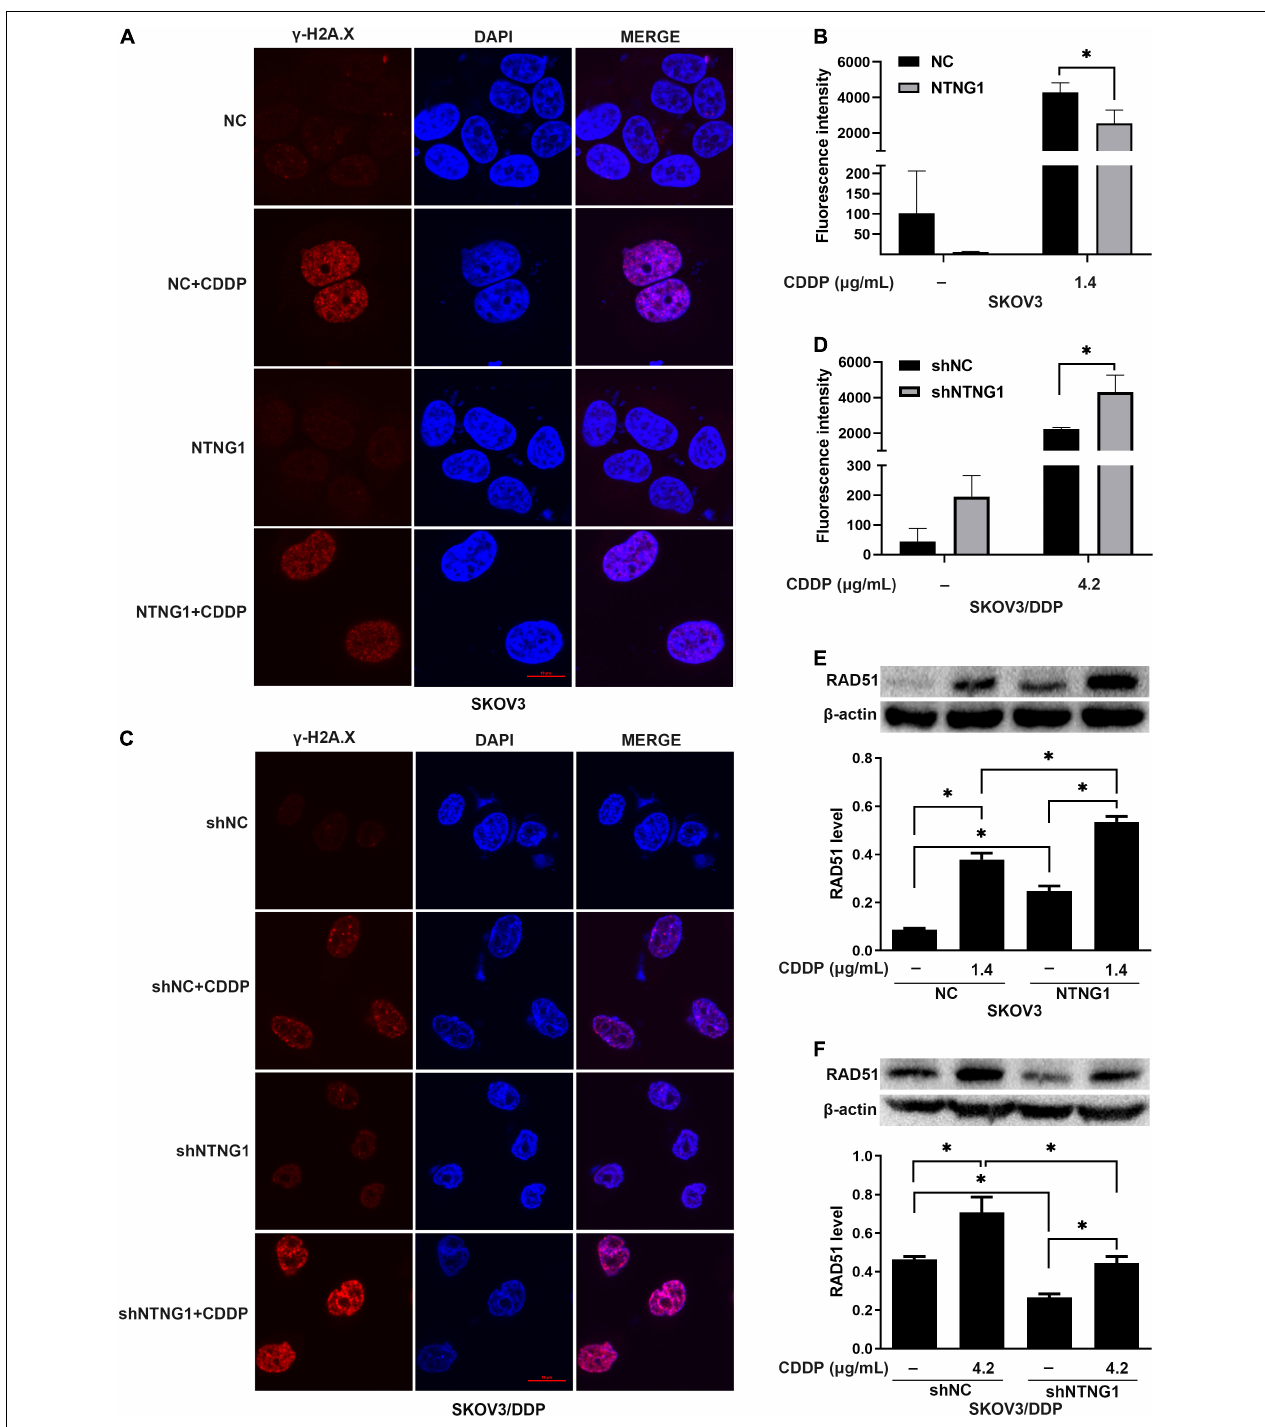
FIGURE 4 | Effects of NTNG1 on DNA damage/repair ( n = 3). (A–D) Immunofluorescent detection of γ -H2A.X; the level was increased in SKOV3 and SKOV3/DDP cells following cisplatin exposure; after cisplatin treatment, the level in NTNG1-transfected SKOV3 cells was lower than that in NC-transfected cells, but a higher level was observed in shNTNG1-transfected SKOV3/DDP cells compared with shNC-transfected cells; scale = 10 µ m. (E,F) Cisplatin induced the expression of RAD51; following cisplatin exposure, a higher level was noted in NTNG1-transfected SKOV3 cells compared with NC-transfected cells, but a lower level was detected in shNTNG1-transfected SKOV3/DDP cells compared with shNC-transfected cells. CDDP, cisplatin. ∗ p < 0.05.